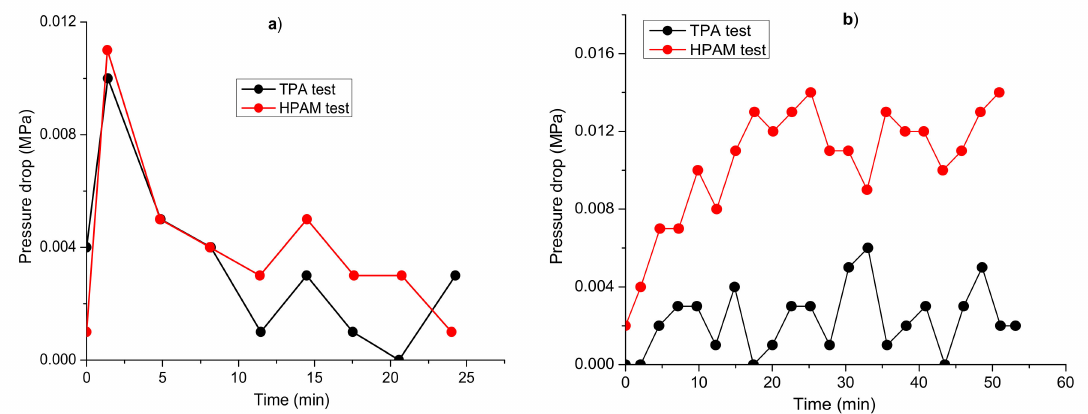
Figure 11. Pressure drops registered during flooding tests in aerated concrete cores with TPA and HPAM for water ( a ) and polymer ( b )